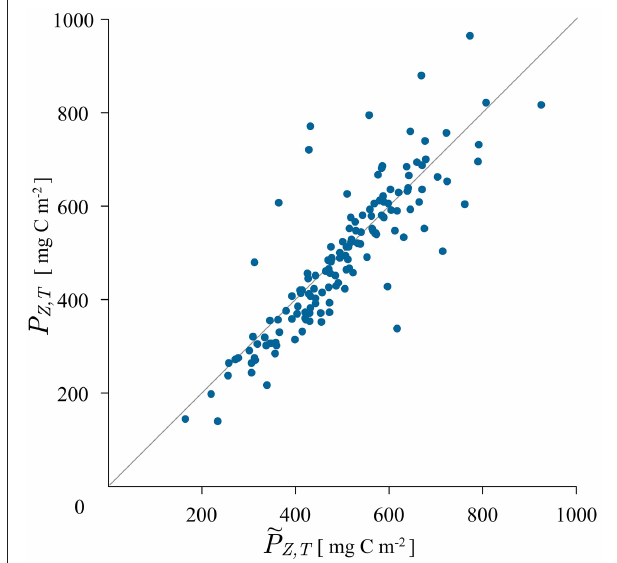
B and modeled biomass B with the FIGURE 3 | Scatter plot of measured shifted Gaussian (21). The first six measurement depths are given in orange, FIGURE 4 | Scatter plot of measured watercolumn production e whereas the data from 150 m measurement depth is given in light gray and the calculated with the trapezoidal rule from the measured production profile, and data from 175 m measurement depth is given in gray. The gray line represents modeled watercolumn production P Z , T , calculated with the analytical solution the 1:1 model vs. data ratio. For the points above/below the gray line the for the shifted Gaussian biomass (24). The solution did not converge for 26, shifted Gaussian overestimates/underestimates the measured biomass. out of 194 tested